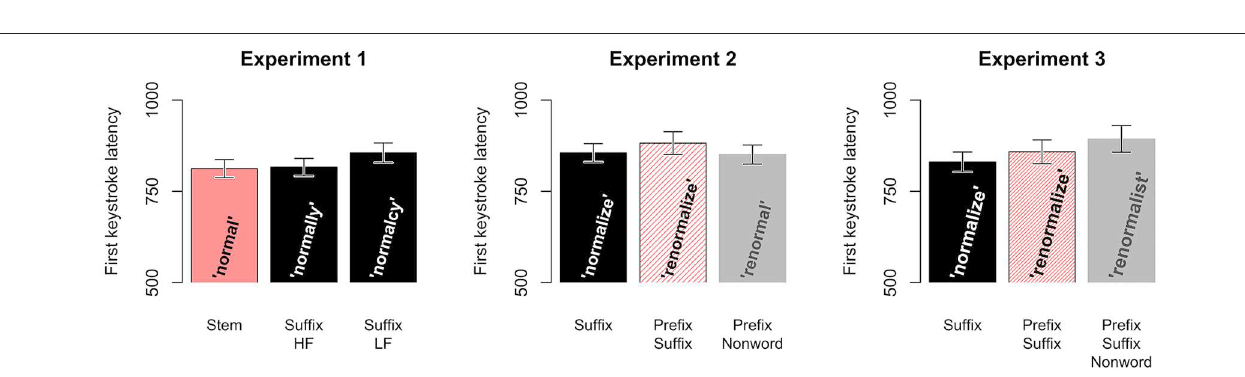
FIGURE 3 | Mean ( ± 1 SE) of the first keystroke latencies in Experiments 1, 2, and